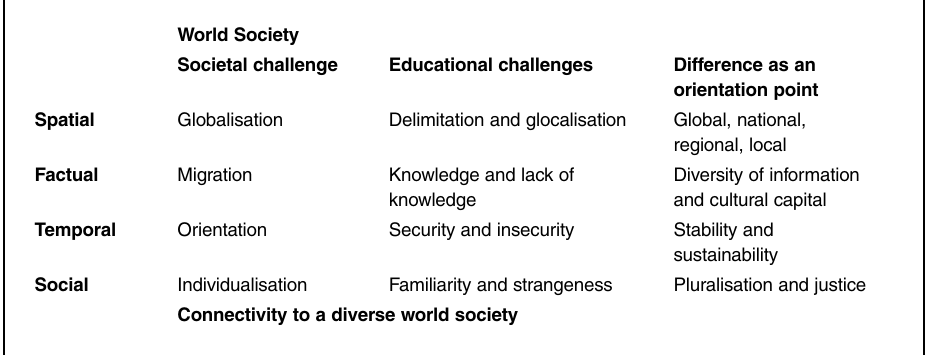
Table 4: World society, challenges and difference as points of